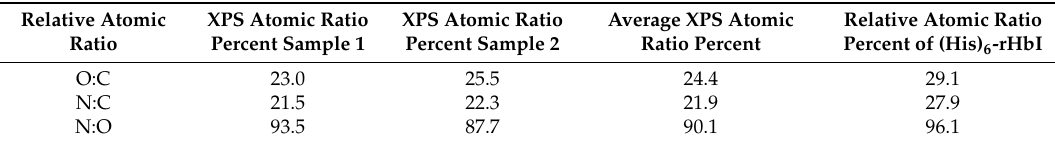
Table 2. The relative ratio from XPS atomic concentration percent of two samples and the atomic relative ratio of the (His) 6 -rHbI calculated from the amino acids sequence